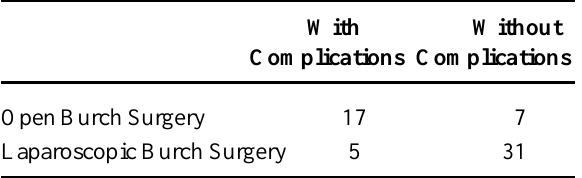
Table 8 – Presence of intercurrences until 90th post-op- erative day ( c 2 = 0.96, p =